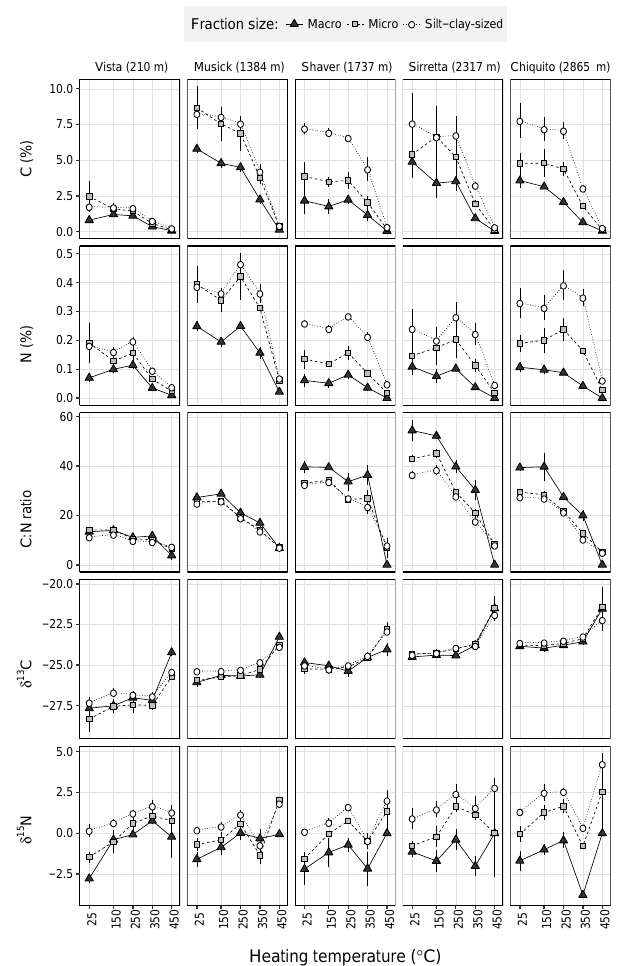
Figure 3. C and N concentrations, C:N atomic ratio, and δ 13 C and δ 15 N isotope (‰) changes in macroaggregates (2–0.25mm), mi- croaggregates (0.25–0.053mm), and silt–clay-sized ( < 0.053mm) aggregates with increase in heating temperature. Error bars repre- sent standard error, where n =